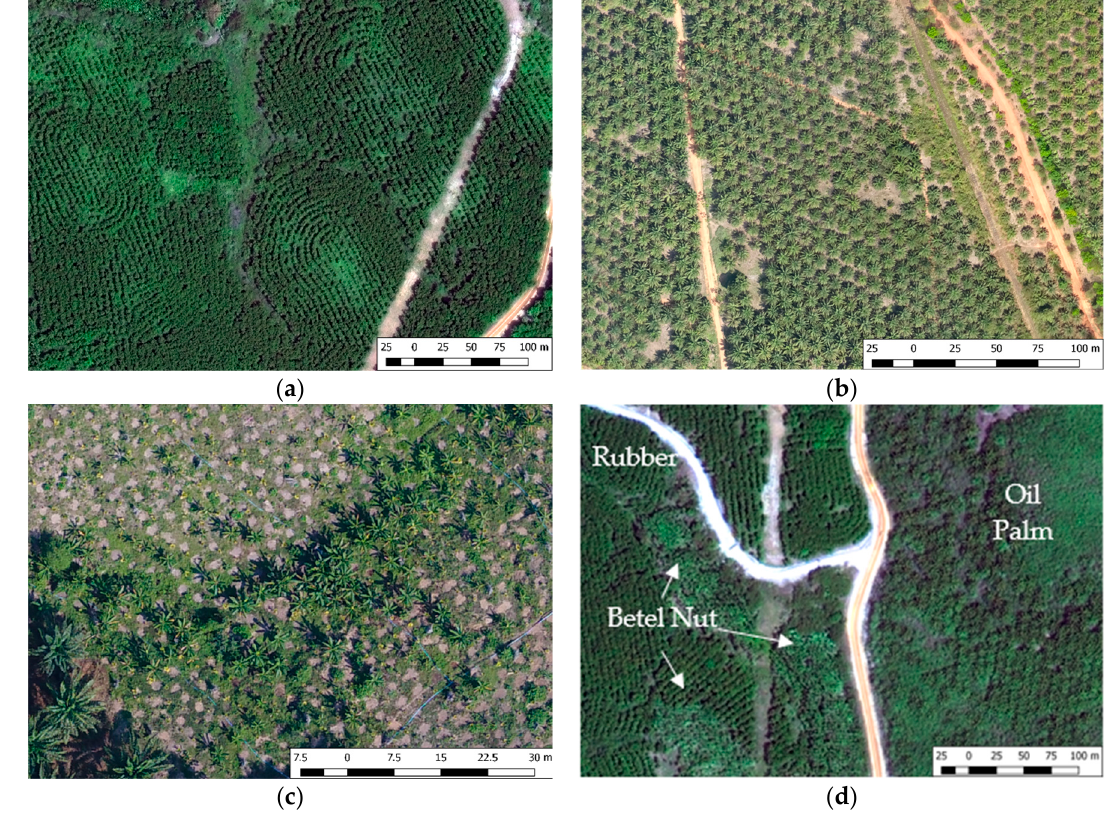
Figure 4. High resolution imagery of the study sites showing ( a ) rubber plantations (WV3); ( b ) oil palm plantation (UAV); ( c ) betel nut trees in comparison to oil palm trees on the lower left (UAV); ( d ) all three crops (WV3). UAV images were provided by the Centre for Development and Environment (CDE)—OneMap Myanmar, Yangon, Myanmar; WorldView-3 imagery © 2018 DigitalGlobe, Inc.—provided by European Space Imaging. North is at the top of each image in the figure.